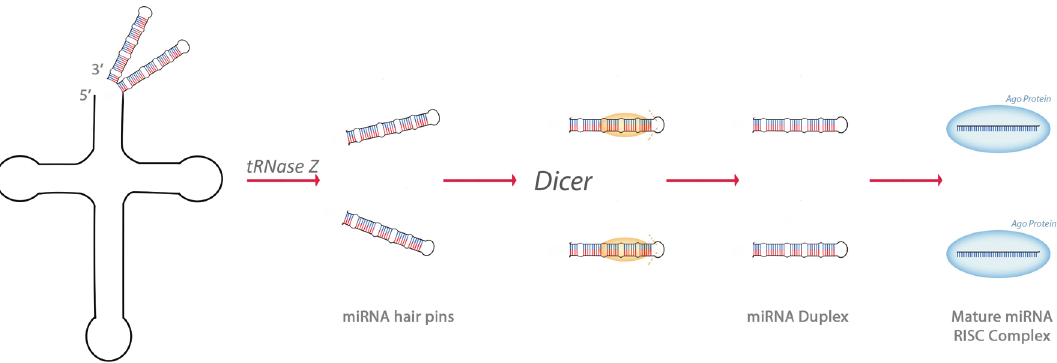
Figure 4 tRNase Z-dependent miRNA. These species of miRNA are believed to be byproducts of the tRNA maturation pathway. The generated pre-miRNAs are then processed by Dicer into mature